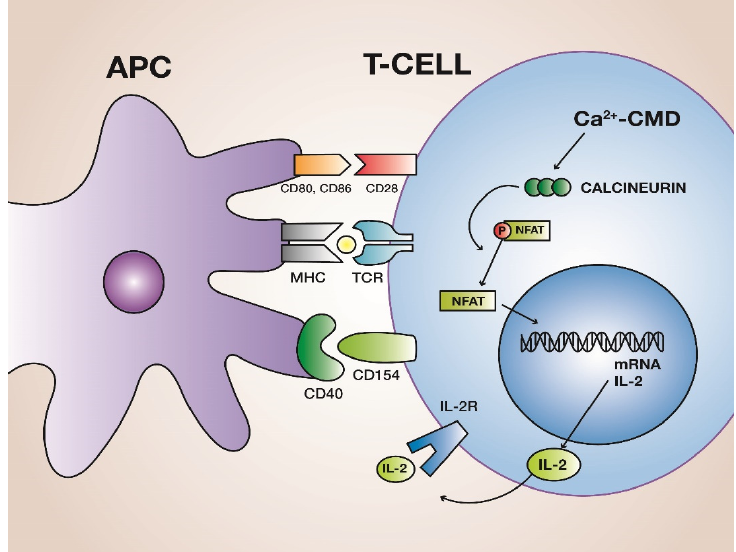
Figure 1. Contact between a peptide of the major histocompatibility complex (MHC) and T-cell receptor (TCR) does not activate naïve T cells. To be activated, T cells also require co-stimulation given by contact between the co-stimulatory molecules of antigen presenting cells (APC), CD80–86, and CD40, and the corresponding molecules on T cell, CD28, and CD 154, respectively. In the activated T cell, there is a large influx of Ca++ ions, which bind to calmodulin (CDM). This complex activates calcineurin, which dephosphorylates NF-AT, allowing its translocation to the nucleus, where NF-AT collaborates in the synthesis of IL-2. IL-2 binds to its receptor (IL-2R), which activates a cascade of kinases, eventually providing the signal for T-cell proliferation and differentiation.